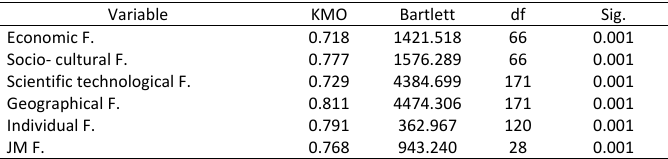
Table 5: KMO and Bartlett’s Test of research variables